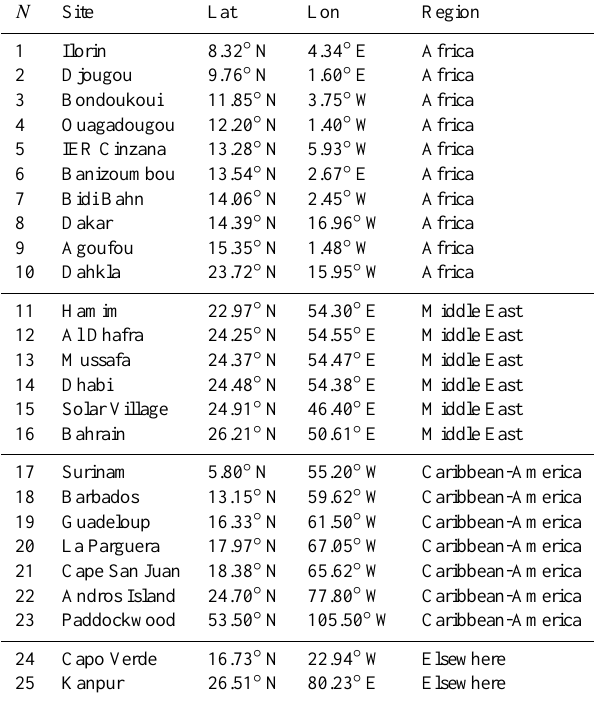
Table 4. “Dusty” sites selected from AERONET according to the data in years 1996–2006. Sites are divided into four groups based on the location. N is the number of each site as shown in Fig.